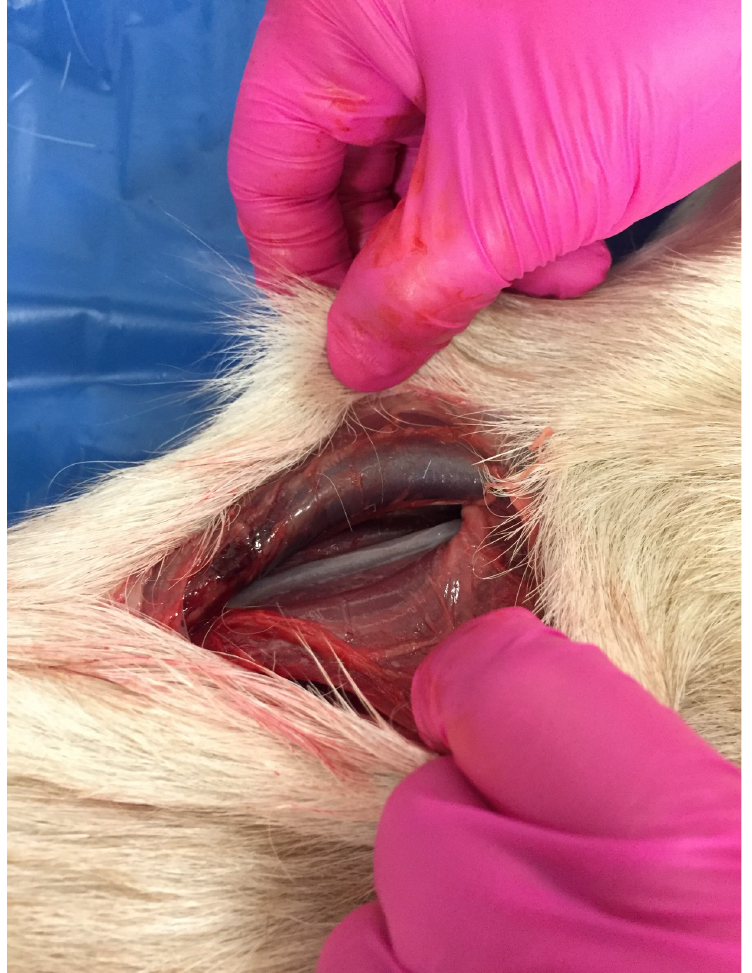
Fig 1. The common carotid artery after cutting the skin and subcutaneous